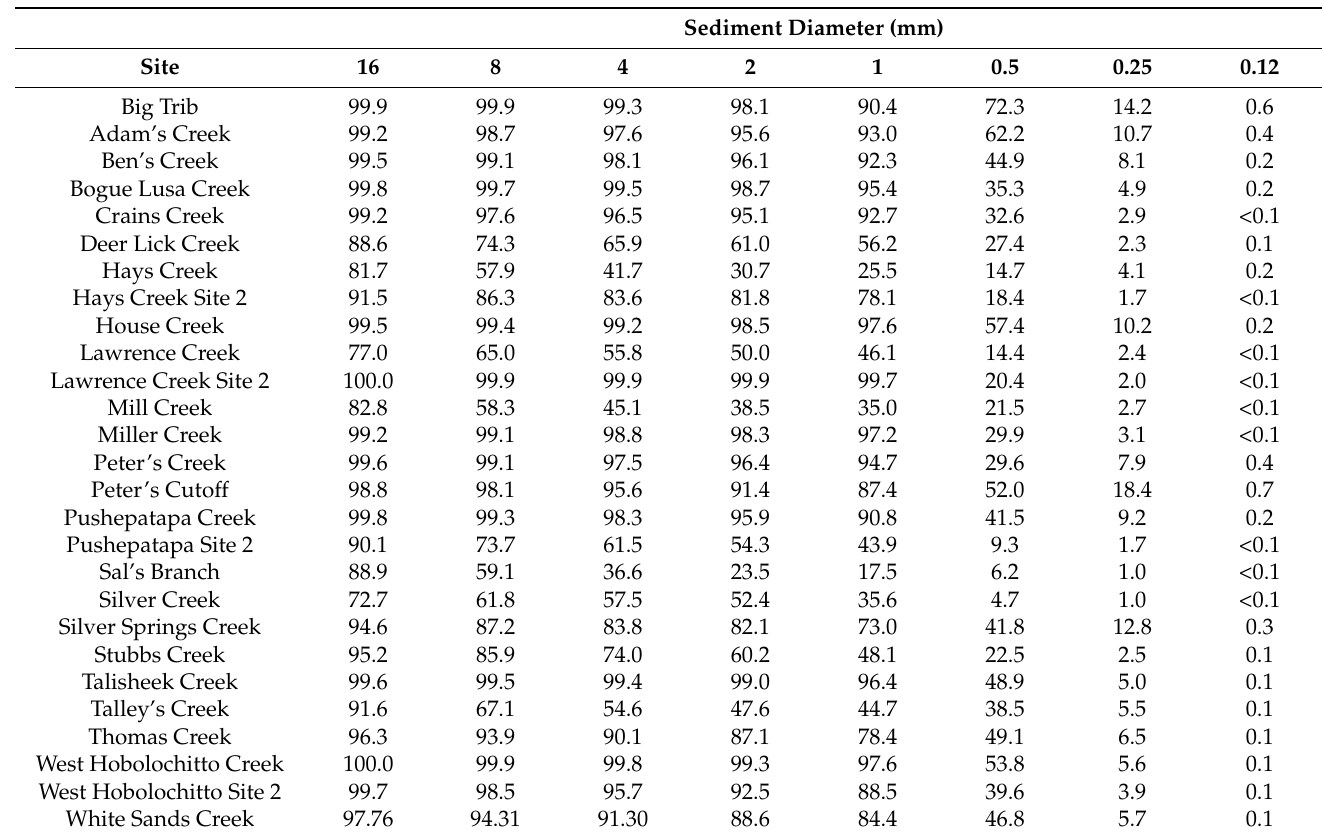
Table 3. Percentage of substrate less than each size class in Pearl River tributary streams sampled in 2015 and 2016.